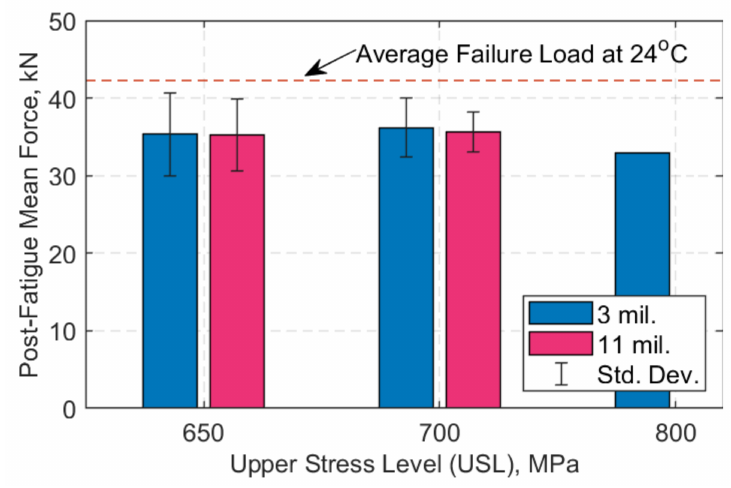
Figure 18. Average force (kN) vs. upper stress level (Mpa); post-fatigue. The remnant strength of the straps at ambient temperature, at an upper stress level (USL) of 650, 700 or 800 Mpa for 3 and/or 11 million loading cycles, is presented in Table 5. Three straps at 700 Mpa, at both 3 and 11 million loading cycles, were tensile-tested post- fatigue, while at a USL of 650 Mpa, four straps were tested after 3 and 11 million loading cycles. At USL of 800 Mpa, only one strap was tested to assess the remnant strength after 3 million loading cycles, since the rest of the straps failed before 3 million cycles. Table 5. Ultimate tensile strength (UTS in Mpa) with average and standard deviation values after fatigue at 60 ◦ C for USLs 650, 700 and 800 Mpa. USL: 650 Mpa USL: 700 Mpa USL: 800 Mpa 3 MIL .